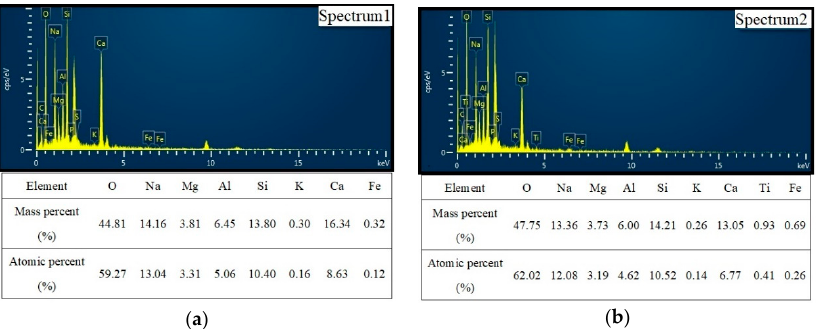
Figure 9. Scanning electron microscope (SEM) image of AASC with a silicate modulus of 1.2 and Figure 10. Energy-dispersive spectrometry (EDS) images of AASC with a silicate modulus of 1.2 and Na 2 O content of 8% after 28 days. Na 2 O content of 8% after 28 days: ( a ) Spectrum 1; ( b ) Spectrum 2.